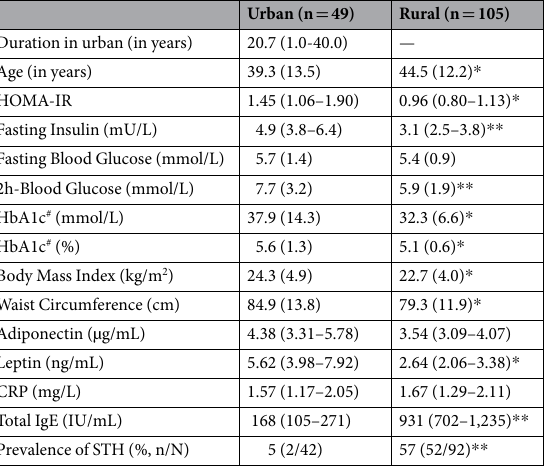
Table 1. Comparison of metabolic profiles between subjects living in urban and rural area. All variables are presented as mean and its standard deviation, however, HOMA-IR, fasting insulin, adiponectin, leptin, CRP, and total IgE level are presented as geomean (95%CI) and were log transformed for analysis, while duration in urban is presented as mean (range). Analysis for the difference between urban and rural group was performed using independent t-test ( * p < 0.05, ** p < 0.0001) # Hba1c measurements were available in 42 and 95 of urban and rural subjects respectively. Abbreviation: HOMA-IR = the homeostatic model assessment of insulin resistance, CRP = C-reactive protein, STH = soil-transmitted